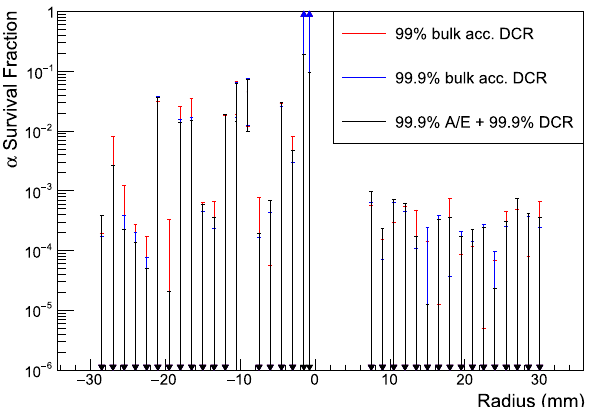
Fig. 11 The α survival probability of three possible α event cuts, applied at each scanning position. The efficiency of the 99% (99.9%) bulk event acceptance DCR cut is given by the red (blue) points. The black points indicate the efficiency of an α event rejection cut using both the DCR and A/E parameters, each applied at the 99.9% bulk event acceptance level. Downward-pointing arrows indicate that the uncertainty given is an upper limit